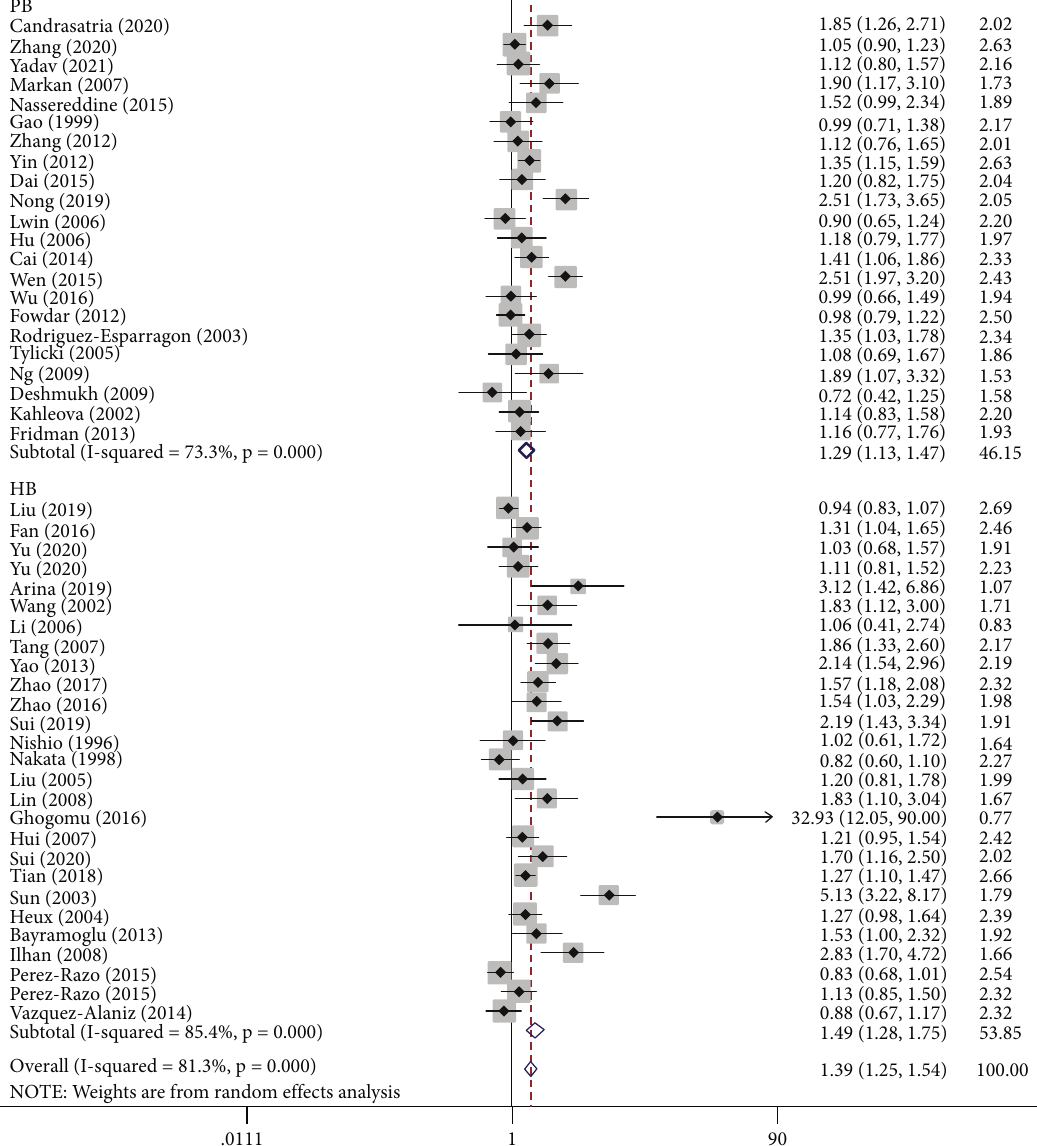
Subtotal (I-squared = 85.4%, p = 0.000) Overall (I-squared = 81.3%, p = 0.000)